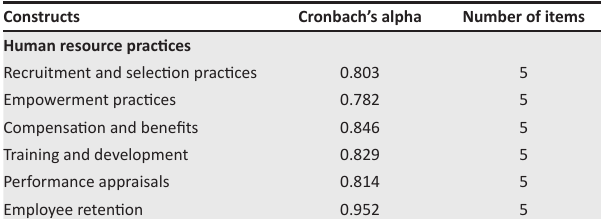
TABLE 2: Results of Cronbach’s